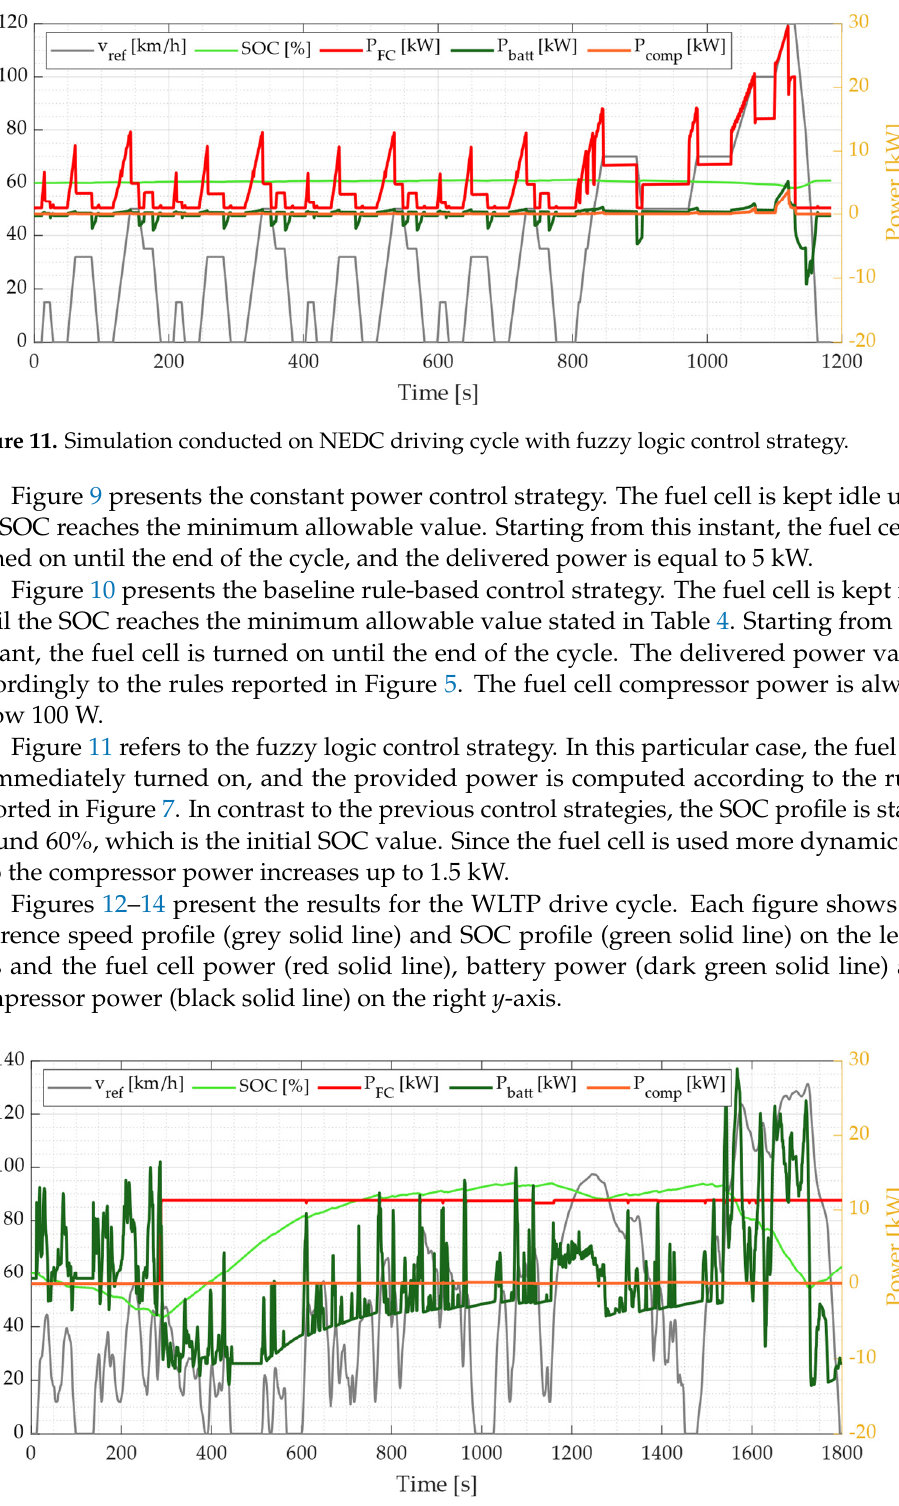
Figure 12. Simulation conducted on WLTP driving cycle with constant power control strategy.